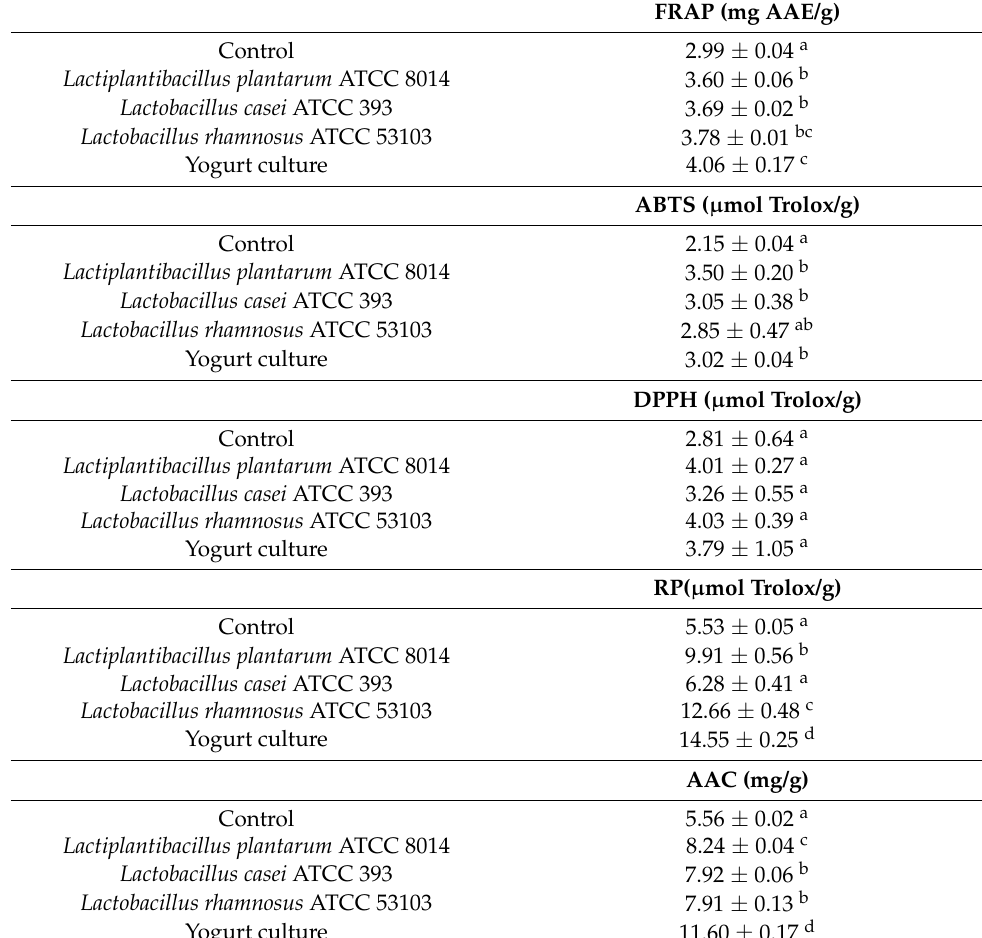
Table 5. Changes in FRAP, ABTS, DPPH, Reducing Power (RP), and Ascorbic Acid Content